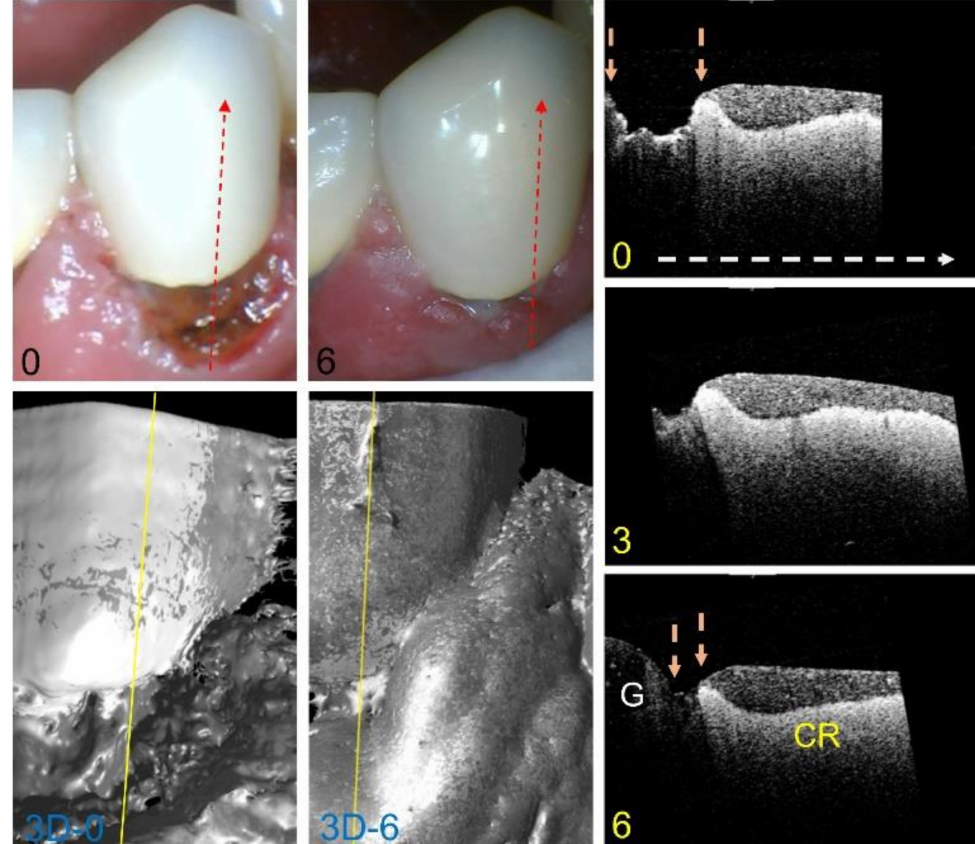
Figure 5. Color pictures at baseline and 6 months of an exposed root surface that becomes completely covered by inflamed gingiva after 6 months. The dashed red lines show the likely position of the three CP-OCT b-scans shown at baseline, 3 months, and 6 months. The white dashed arrow in the OCT b-scan is directed from the root to the crown. Surface renderings (3D) of the entire CP-OCT scans taken at baseline and 6 months are also shown, with the yellow lines showing the position of the extracted b-scans. The position of the gingiva (G) and the attached crown (CR) are indicated. After 6 months, the exposed root surface indicated by the position between the two arrows has contracted markedly and the 3D surface rendering shows most of the root surface that was exposed at baseline is now covered by the expanded